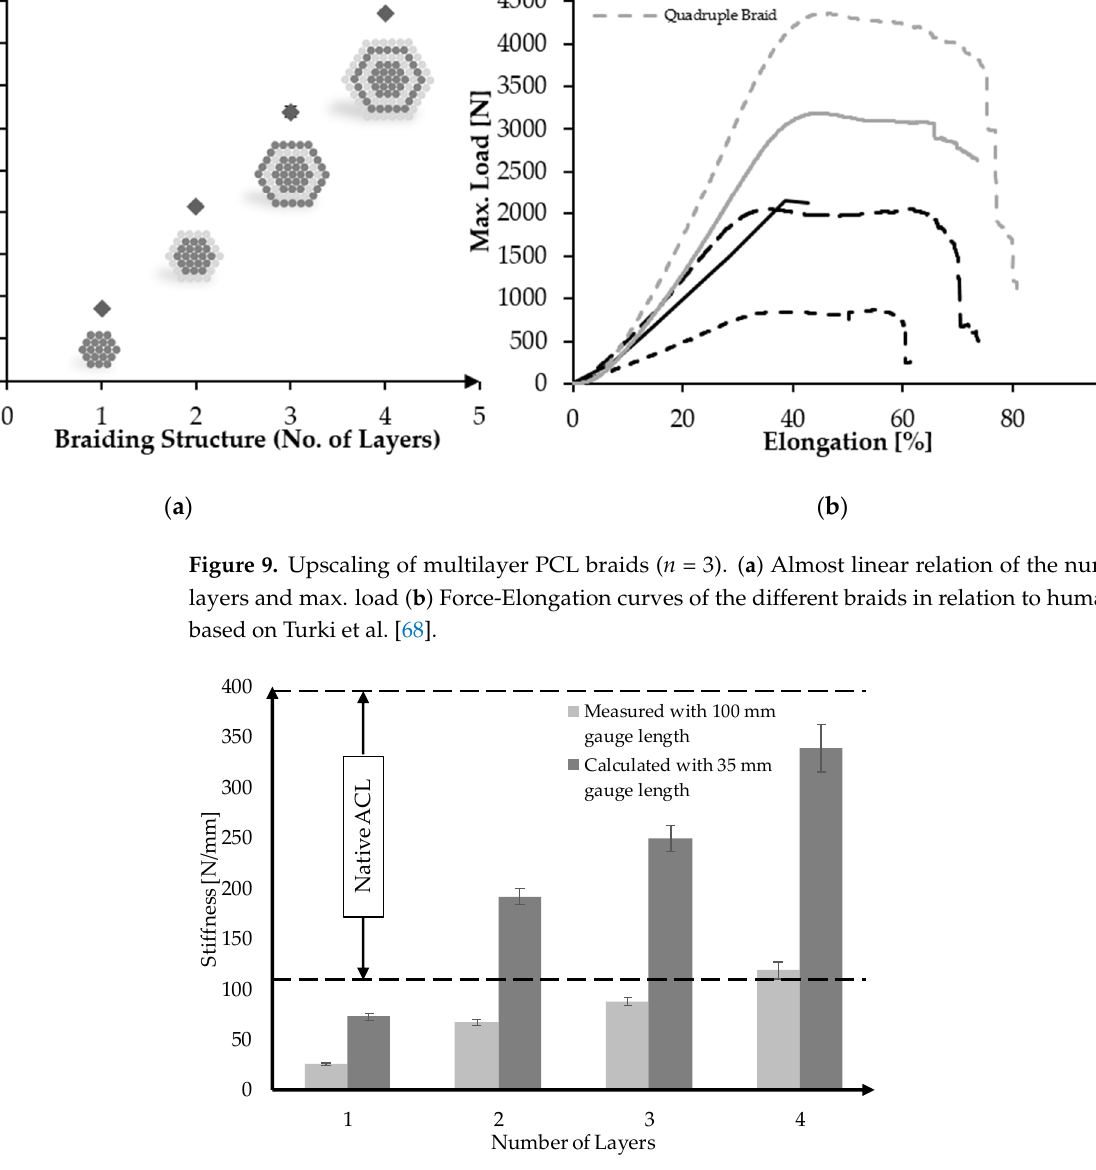
Figure 10. Stiffness derived from tensile tests (linear slope, n = 3) and calculated for an average human ACL length of 35 mm. The range of the native ACL’s stiffness is indicated in dashed lines. [6].